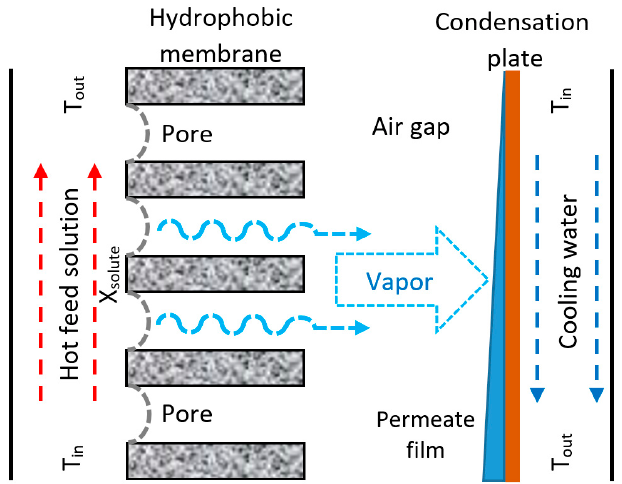
Figure 1. Air gap membrane distillation process schematic diagram.